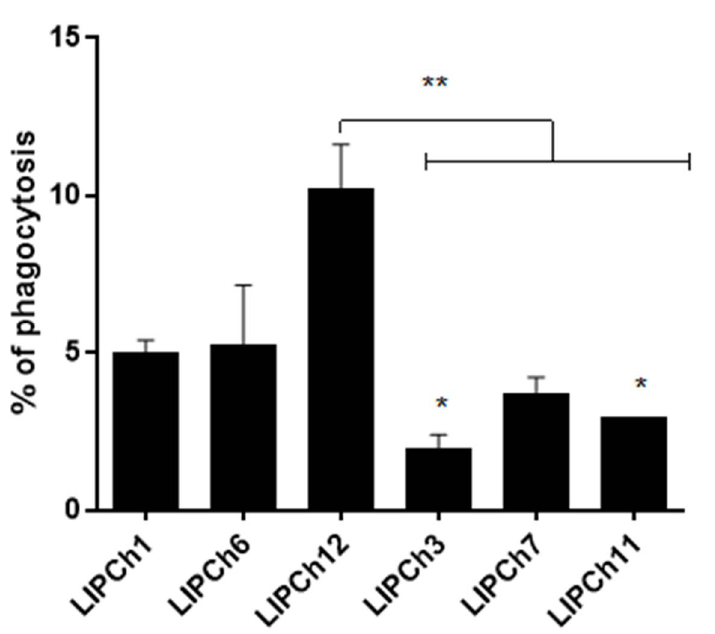
Figure 4. Larvae were infected with 5 × 10 4 cells of C. haemulonii complex (LIPCh1; LIPCh6; LIPCh12; LIPCh3; LIPCh7; LIPCh11) and after 3 days of infection the hemolymph was extracted. A smear in glass slide was prepared and stained with Wright dye. Per group were used 100 hemocytes to obtain the phagocytic percentage. ** Indicates statistical significance ANOVA with post-Tukey’s test, p < 0.05 and * Indicates statistical significance t -test compared to C. haemulonii with low virulence (Ch1 and Ch6). Error bars represent standard deviations between samples (biologic replicates) from the same group.